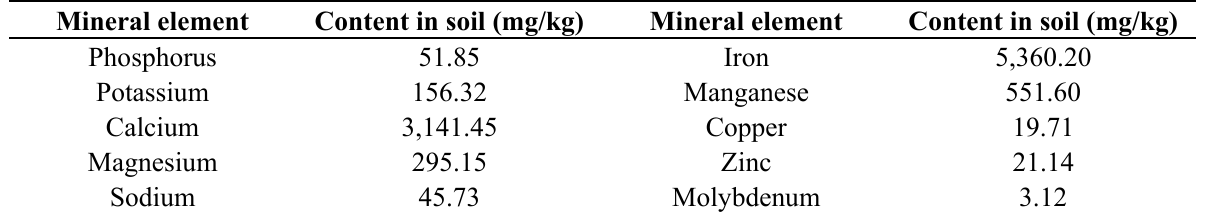
Table 5. Agrochemical characteristics of the soil used